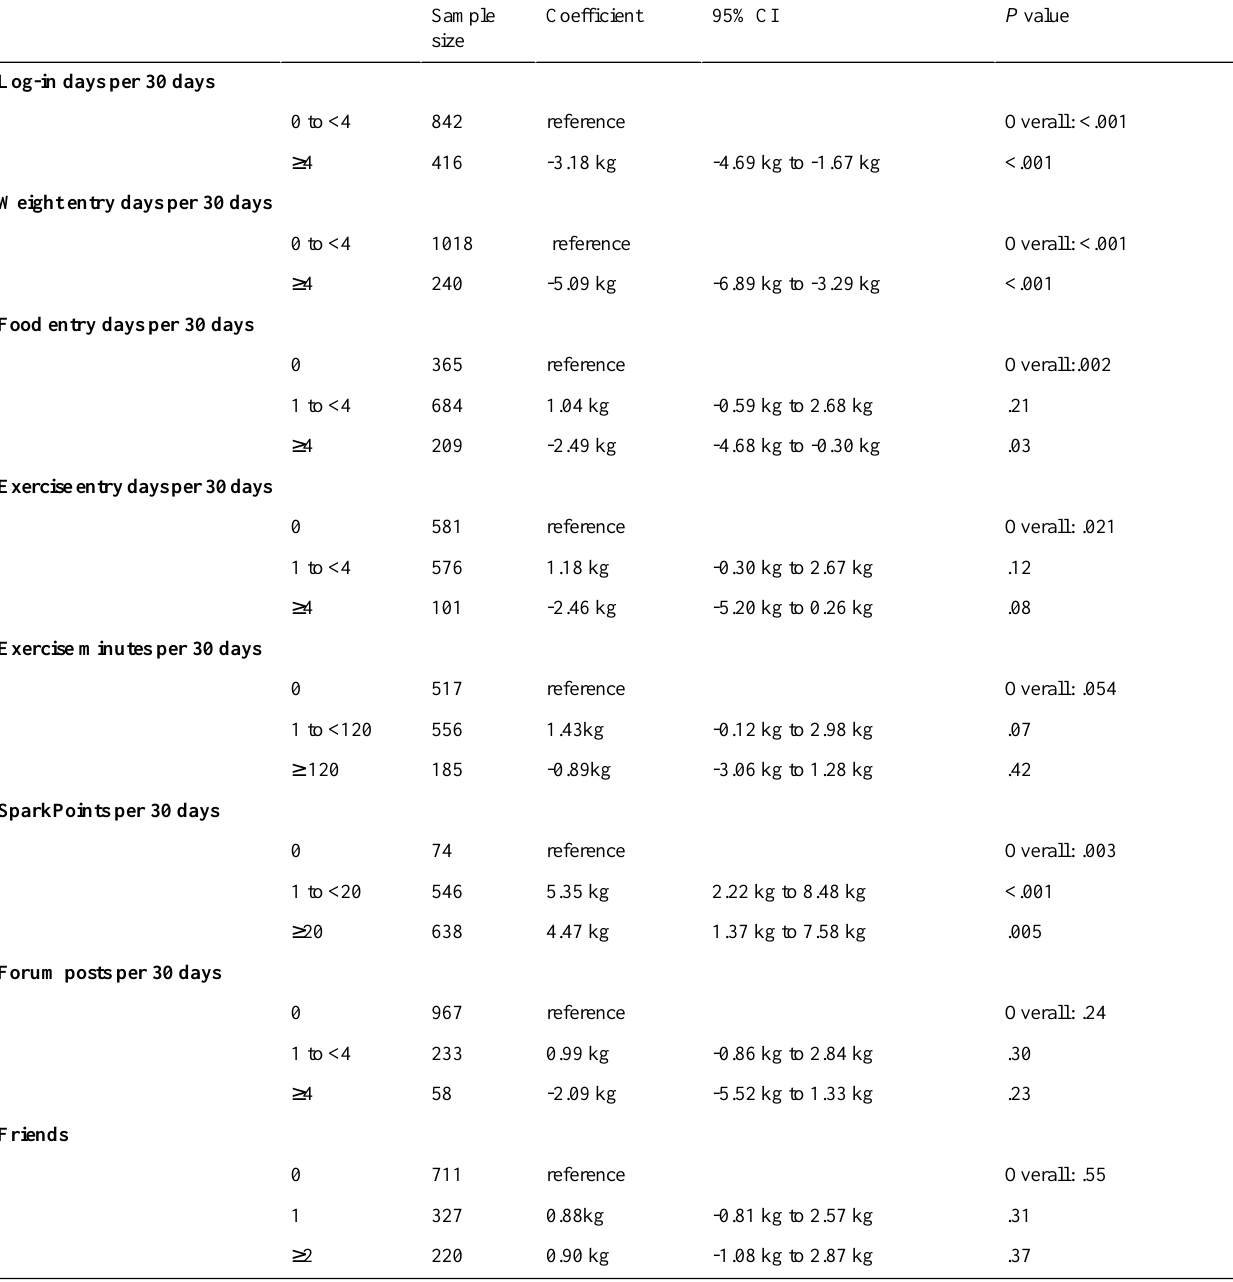
Table 5. Univariable analyses of associations between website usage variables (categorized) per 30 days and reported weight change per 30 days a in the final cohort